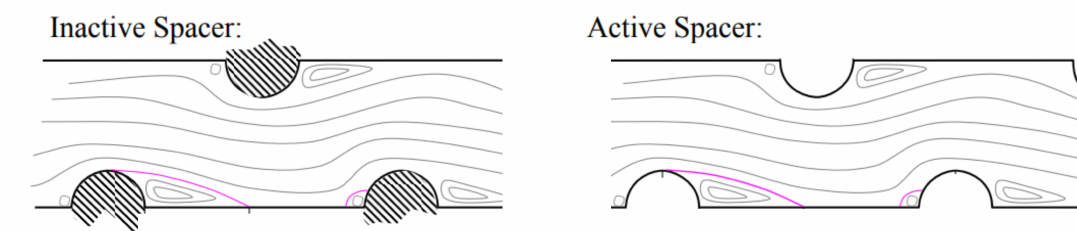
Figure 2. Illustration of active and inactive spacer-filled channels with developed wakes in reattachment region. Inactive spacers ( left side ) suppress local ion migration through the membrane, while active spacers ( right side ) are